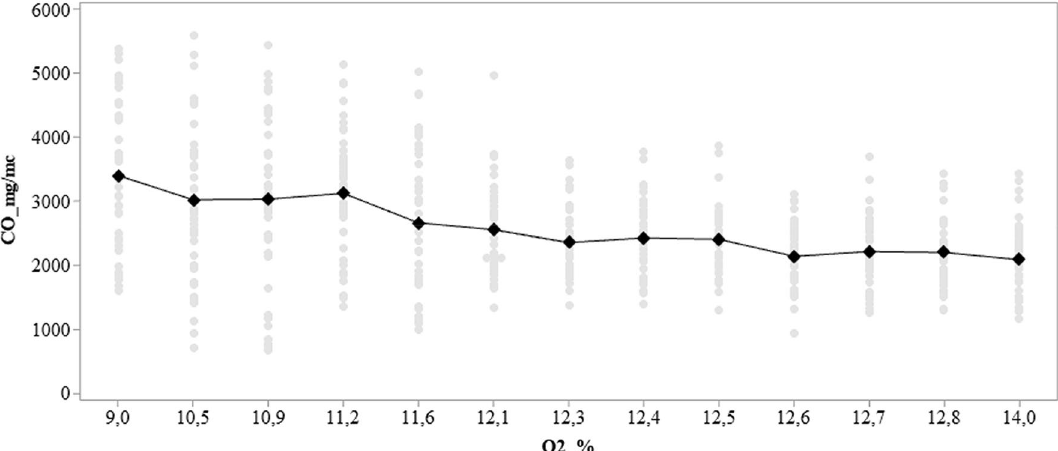
Figure 6. The decreasing CO trend is evident as the O 2 content increases.The average CO trend tends to decline as the oxygen content increases.The oxygen levels represented on the X-axis reproduce the most frequent oxygen values found.